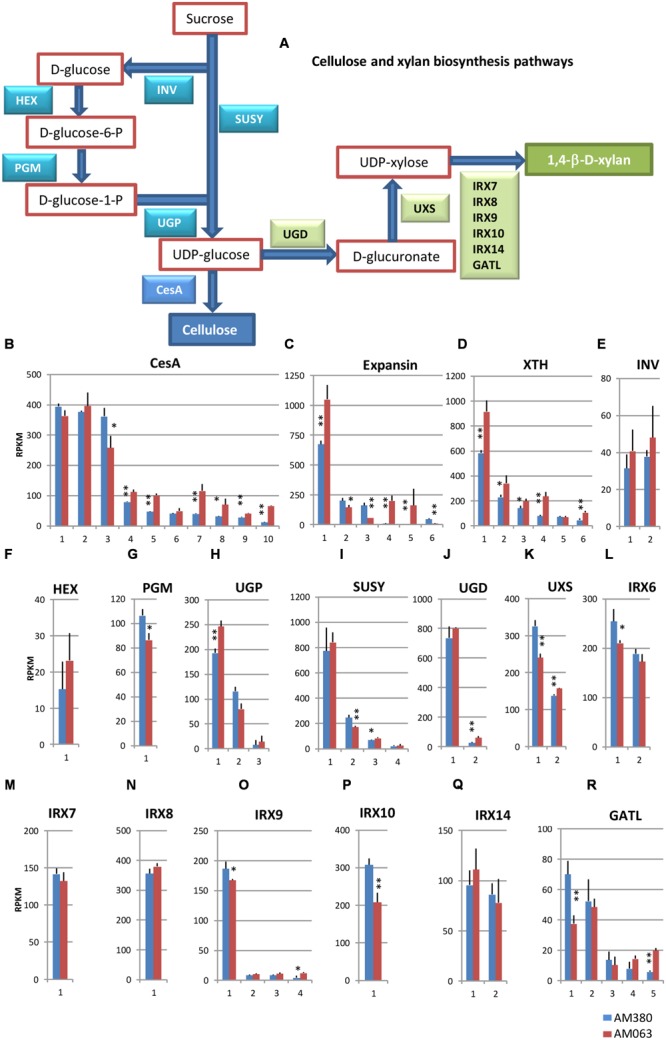
Cellulose and xylan biosynthesis pathways (A) and comparison of the transcript profiles of selected genes related to cell wall construction, CesA (B), Expansin (C), XTH (D), INV (E), HEX (F), PGM (G), UGP (H), SUSY (I), UGD (J), UXS (K), IRX6 (L), IRX7 (M), IRX8 (N), IRX9 (O), IRX10 (P), IRX14 (Q), and GATL (R). RNAs were extracted from developing xylem tissues of each genotype. Numbers on the X-axis represent gene numbers listed in Table S1. RPKM values are plotted on Y-axis. The data collected from three independent repeats were analyzed. Mean values and standard deviations are shown with error bars. Asterisks or double asterisks indicate significant differences at p < 0.05 or p < 0.01, respectively.